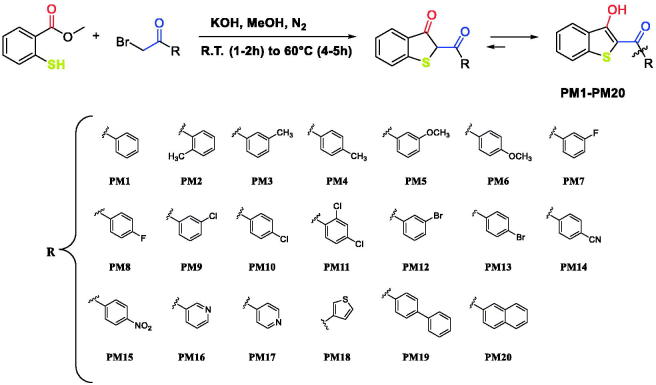
Synthesis of compounds PM1-PM20.